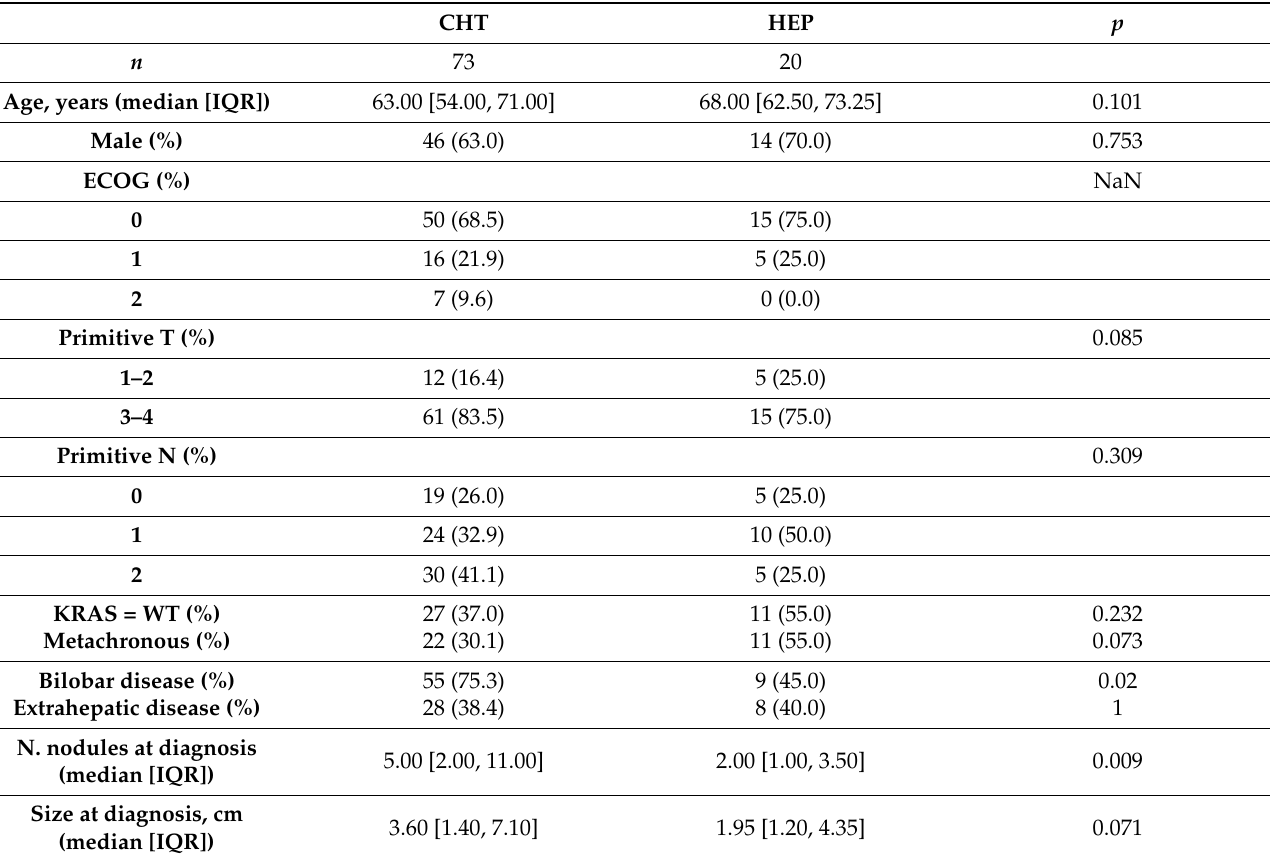
Table 3. Baseline characteristics of the cohort submitted to second line chemotherapy before being considered for surgery.